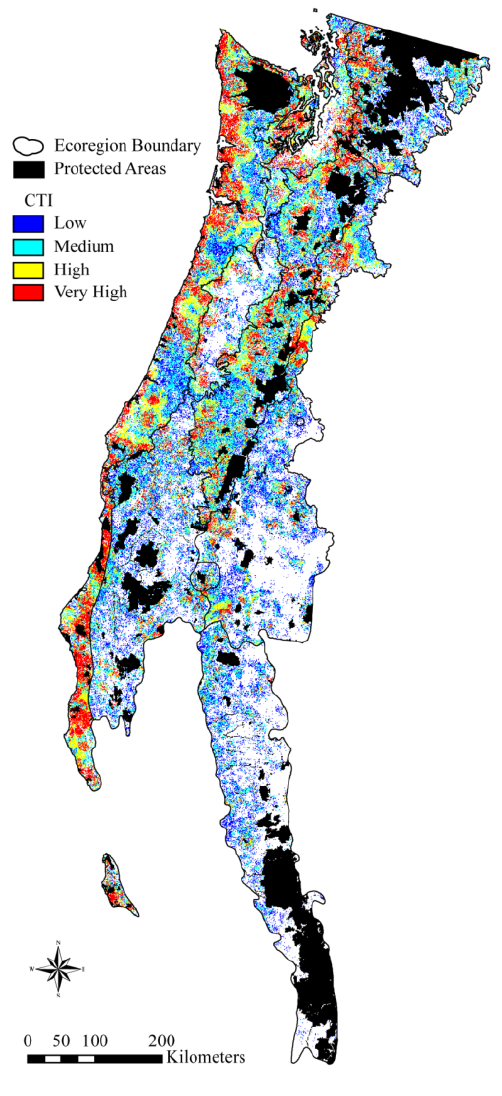
Figure 7. Conversion threat index (CTI) in the Pacific Northwest from 2000 to